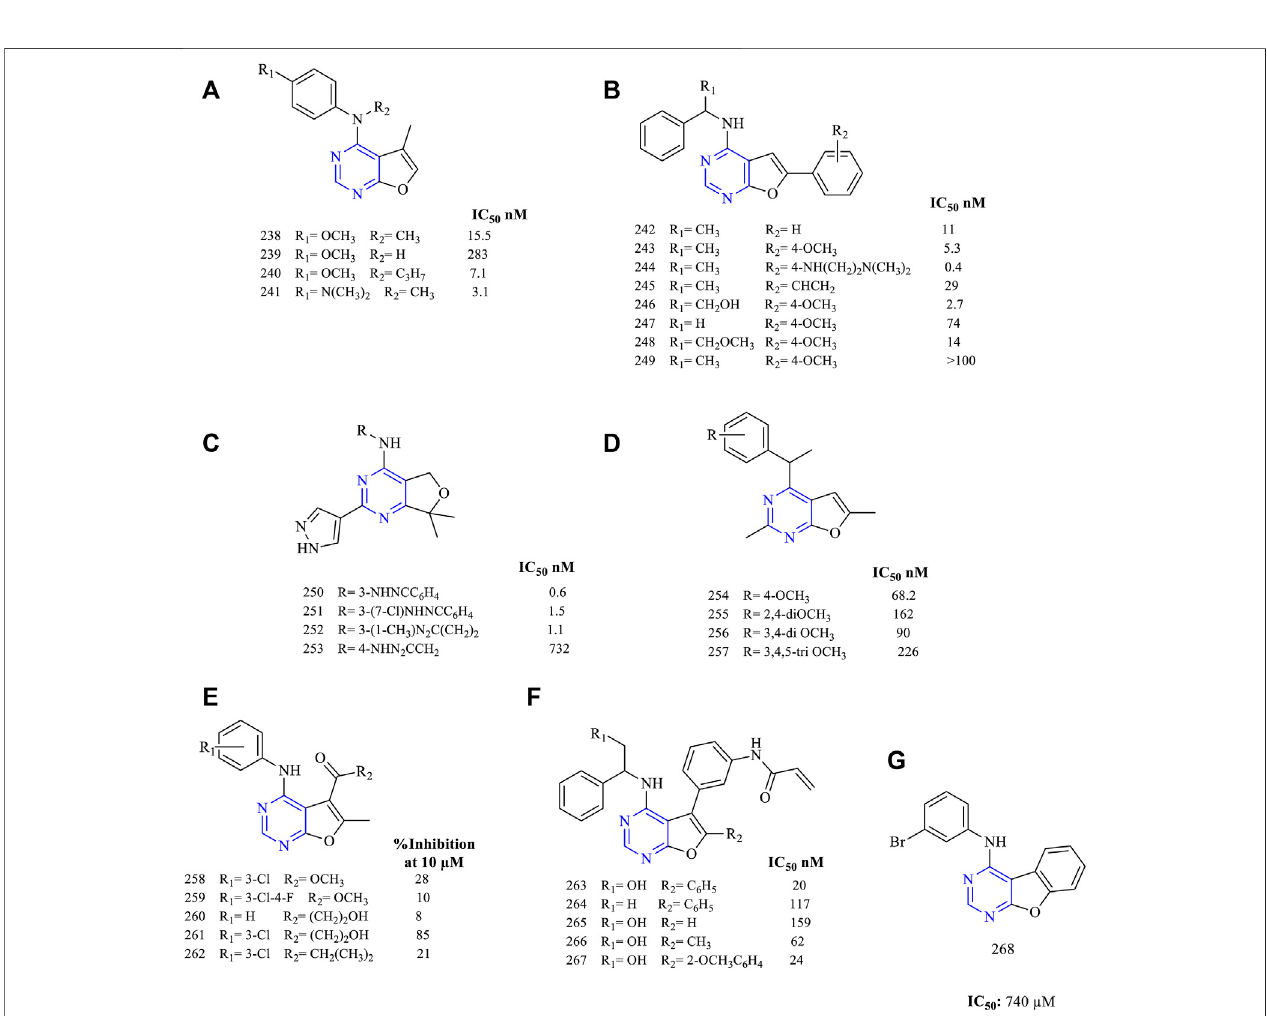
FIGURE 17 | Chemical structure of (A) 4-amino-5-methylfuro[2,3- d ]pyrimidine, (B) 6-arylsubstituted furo[2,3- d ] pyrimidin-4-amine, (C) 2-indazolesubstituted furo [2,3- d ] pyrimidin-4-amine, (D) 4-substituted-2,6-dimethylfuro[2,3- d ]pyrimidine, (E) 4-anilino-6-methylfuro[2,3- d ] pyrimidin-5-carboxylate, (F) propenamide derivatives of furo[2,3- d ]pyrimidine, and (G) phenyl fused furo[3,2- d ]pyrimidine.